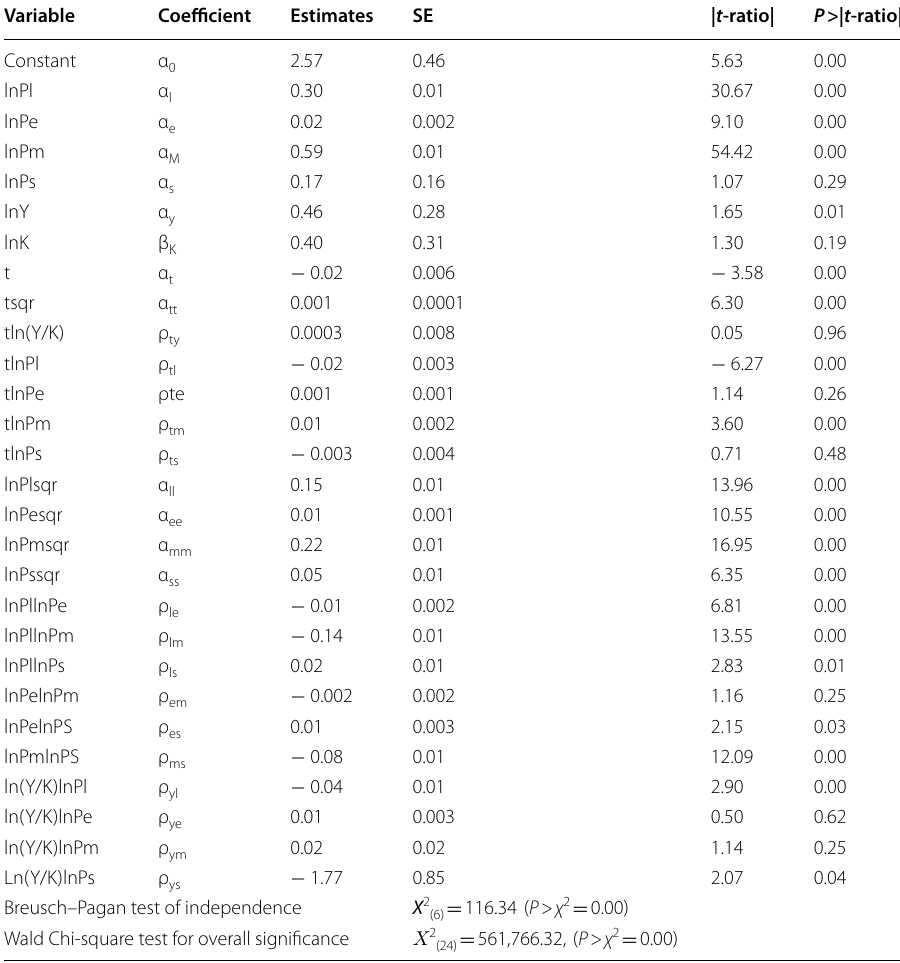
Table 2 Estimation results for restricted cost